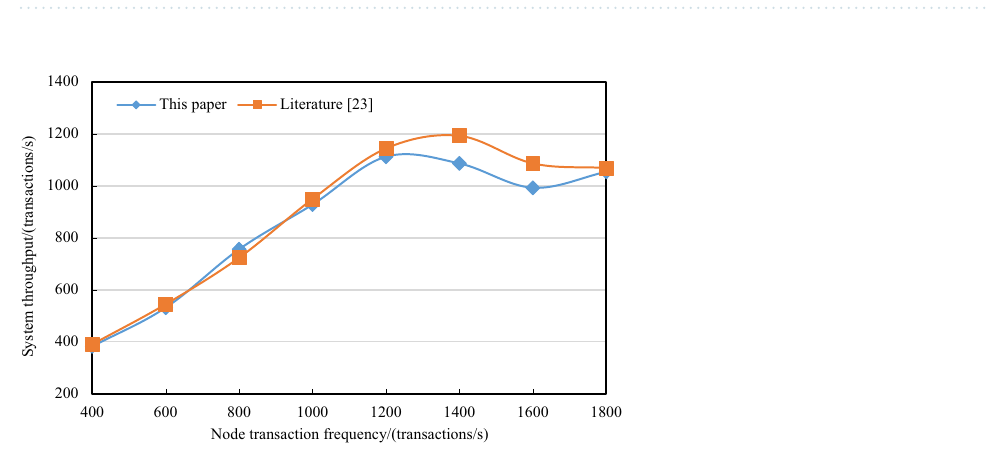
Figure 14. Comparison of system transaction